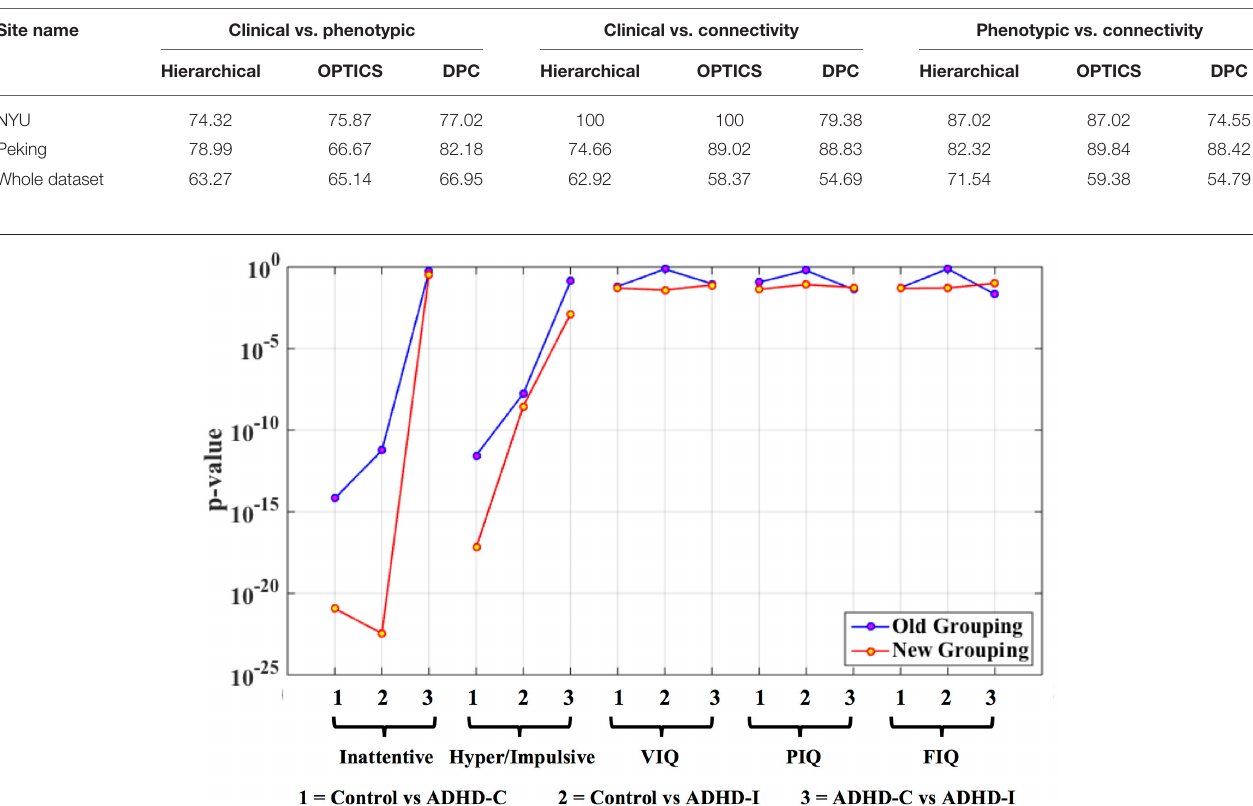
TABLE 13 | Similarity achieved using data from individual sites and for the whole dataset using features commonly selected by NYU and Peking.